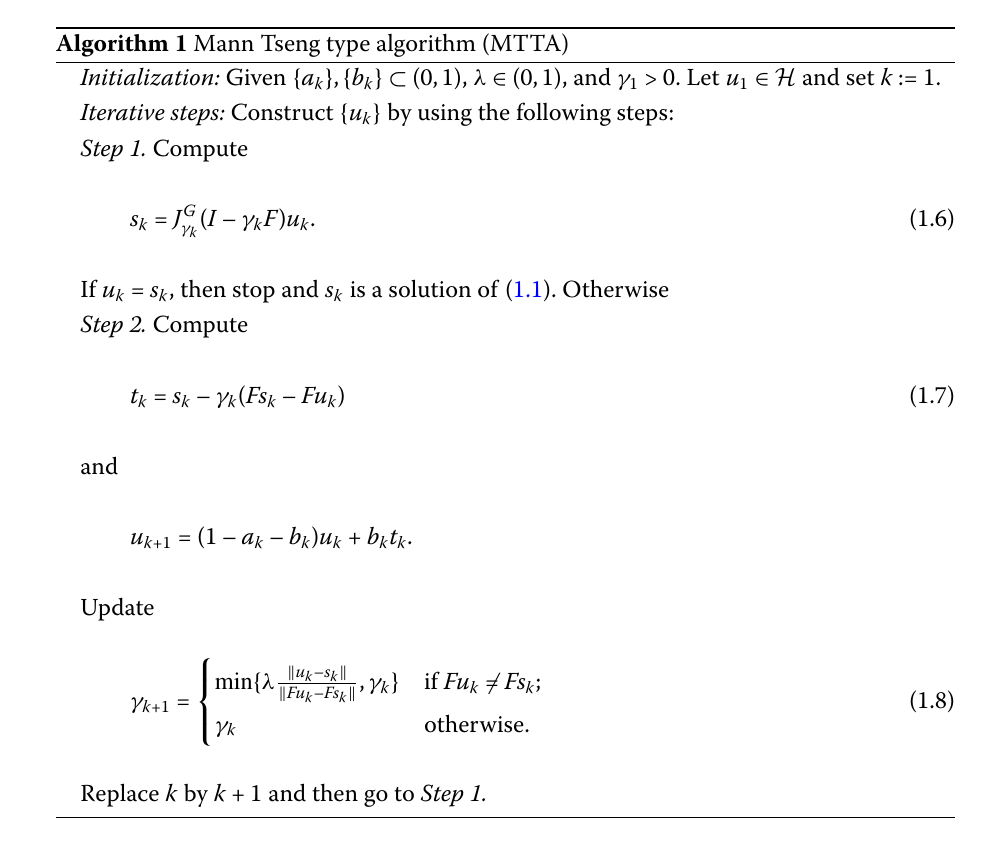
Algorithm 2 Viscosity Tseng type algorithm